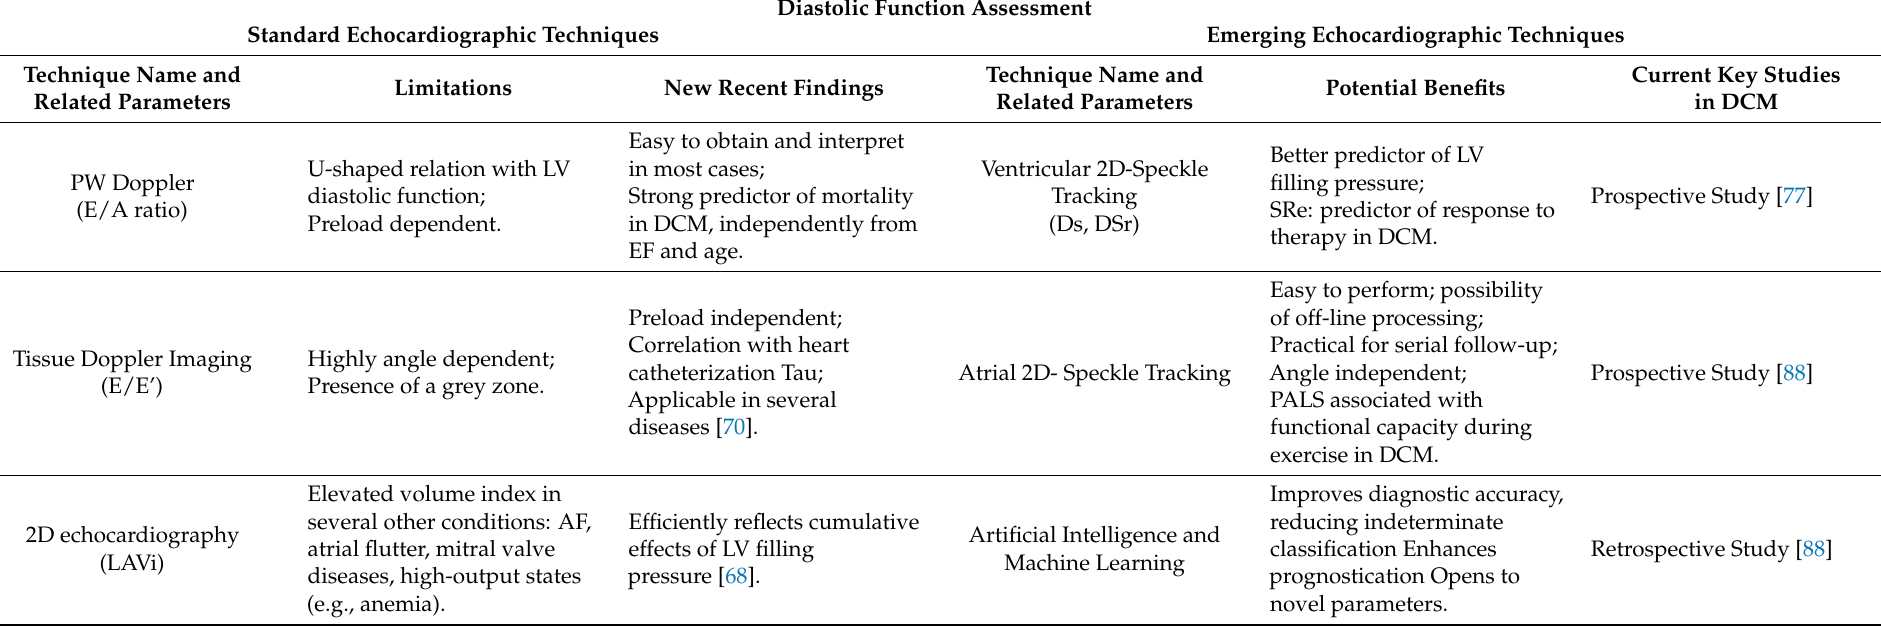
Table 2. Comparison between Standard and Emerging echocardiographic techniques to assess diastolic function in dilated